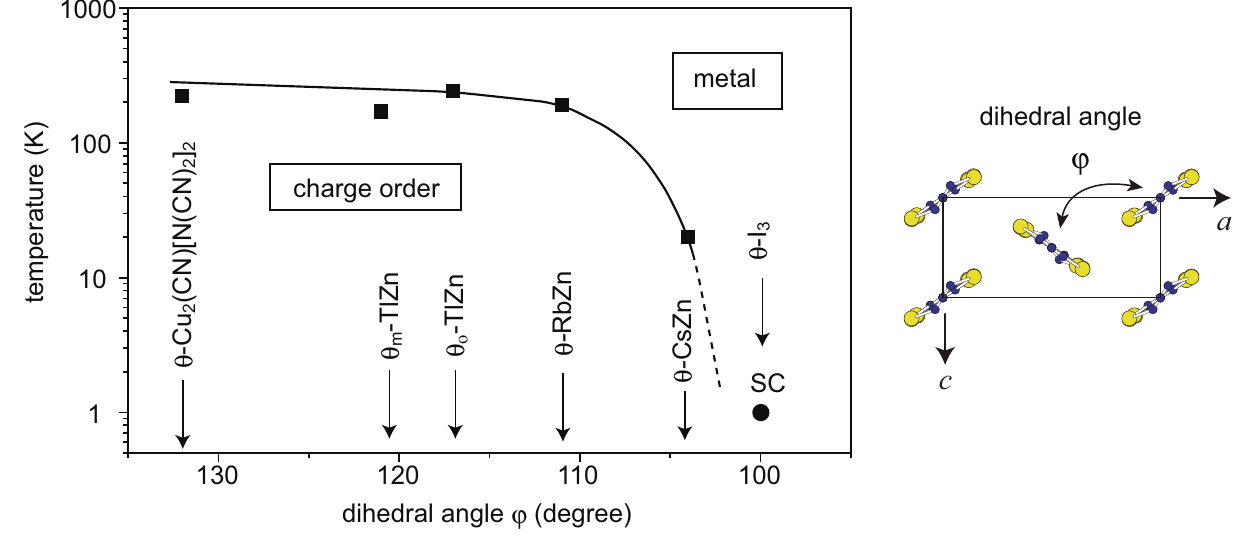
X [79]. The squares and the circle represent Figure 9. Phase diagram of θ -(BEDT-TTF) 2 the charge-ordering phase transition and the superconducting phase transition,